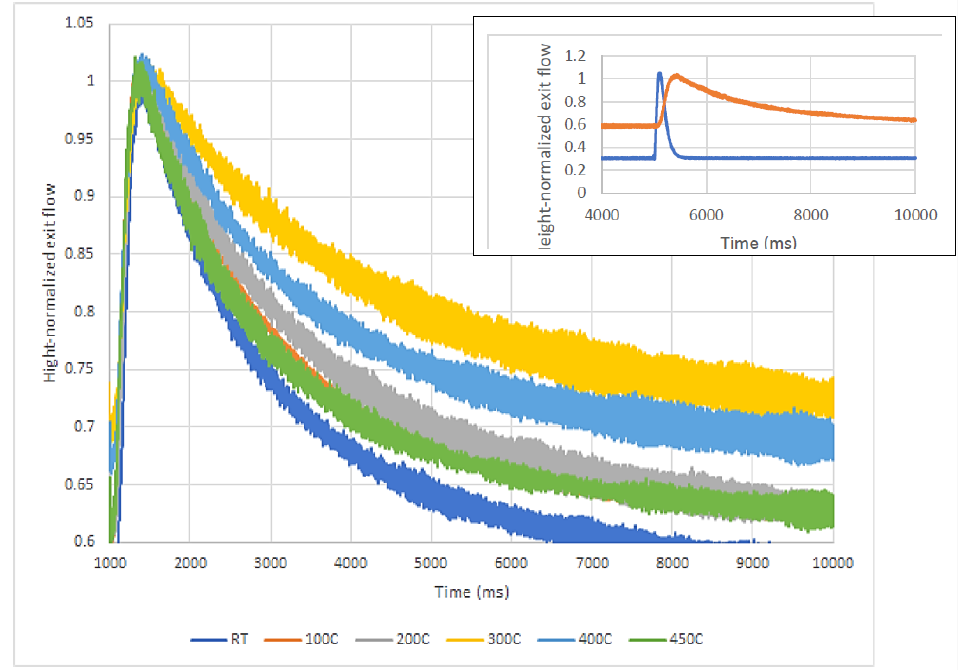
Figure 7. H 2 response to H 2 single-pulse experiments at RT, 100, 200, 300, 400, and 450 °C over the 5 mg catalyst. Inset: H 2 response to H 2 single-pulse experiments at RT in empty (blue) and microreactor filled with 5 mg catalyst (orange). Note: The main and the inset figures have a different time origin because when the experiments were performed over the empty microreactor, the delay between the pulses was set at 5000 ms only, whereas when experiments were performed over the microreactor filled with catalyst, the delay between the pulses was set at 1000 and 5000 ms.